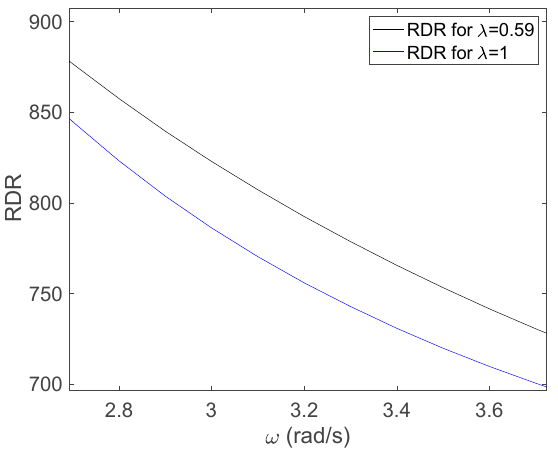
Figure 7. RDR vs. disturbance signal frequency spectra for a simple first-order process. The closed-loop simulation results for reference tracking are indicated in Figure 8.